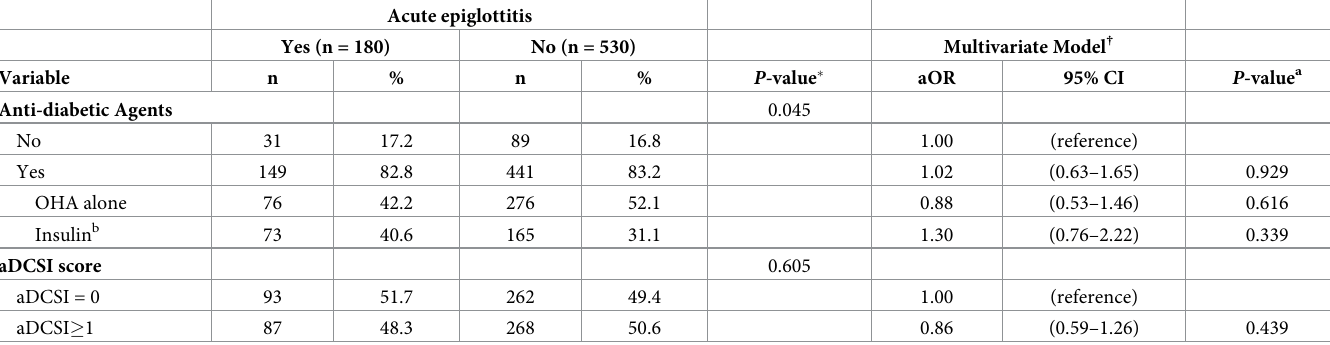
Table 4. Odds ratios for acute epiglottitis with regards to anti-diabetic agents and diabetes related complications among DM